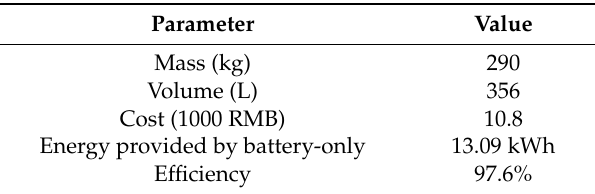
Table 7. The parameters of battery-only pack.